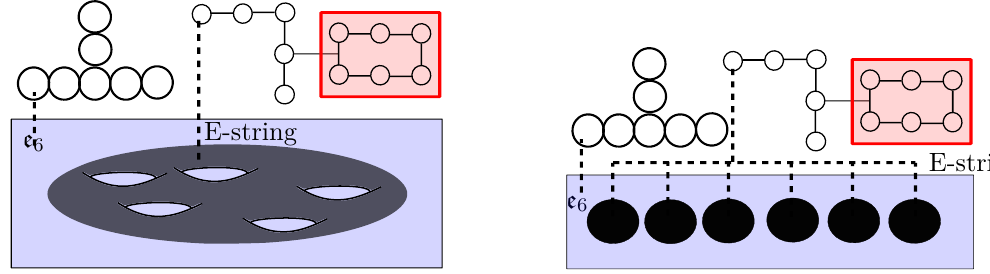
Figure 5 . Depiction of the fiber structure of the e 6 divisor in blue. The left shows an E-string fiber over a genus five curve resolved as a non-flat fiber. On the right a base change has deformed this curve into six genus zero curves that are removed by additional blow-ups. All transitions change the Hodge numbers but not the Euler number of the compact